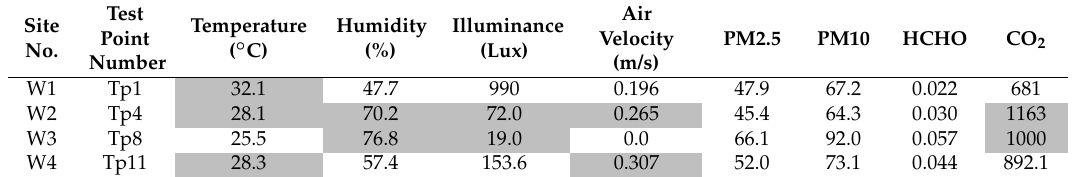
Table 5. Average values for the physical test results in the middle tubular space.